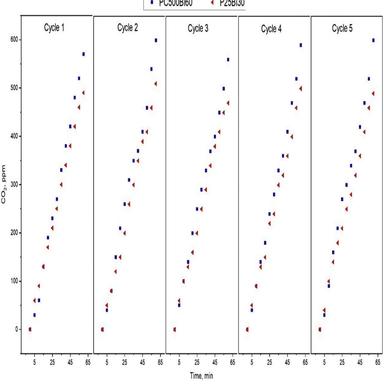
Example of CO2 evolution during 5 cycles of acetone degradation over samples PC500Bi60 and P25Bi30 under visible light irradiation